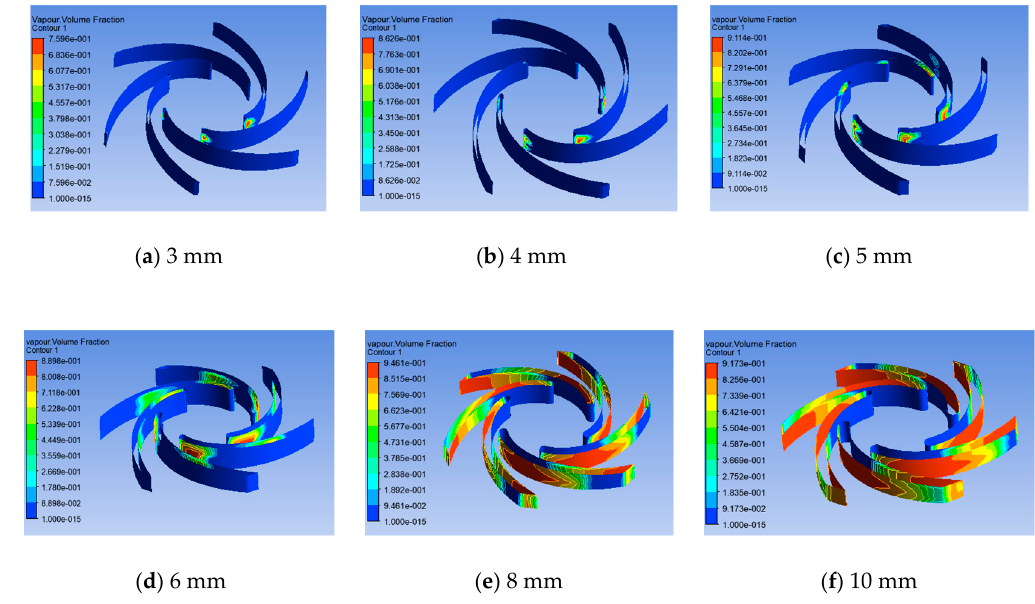
Figure 6. Vapor volume fraction on blade surface of CTB (NPSH = 4.8 m).